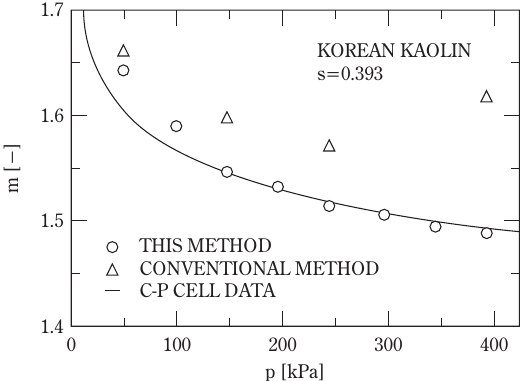
Fig. 3 Relation between ratio of wet to dry cake mass and filtra- tion